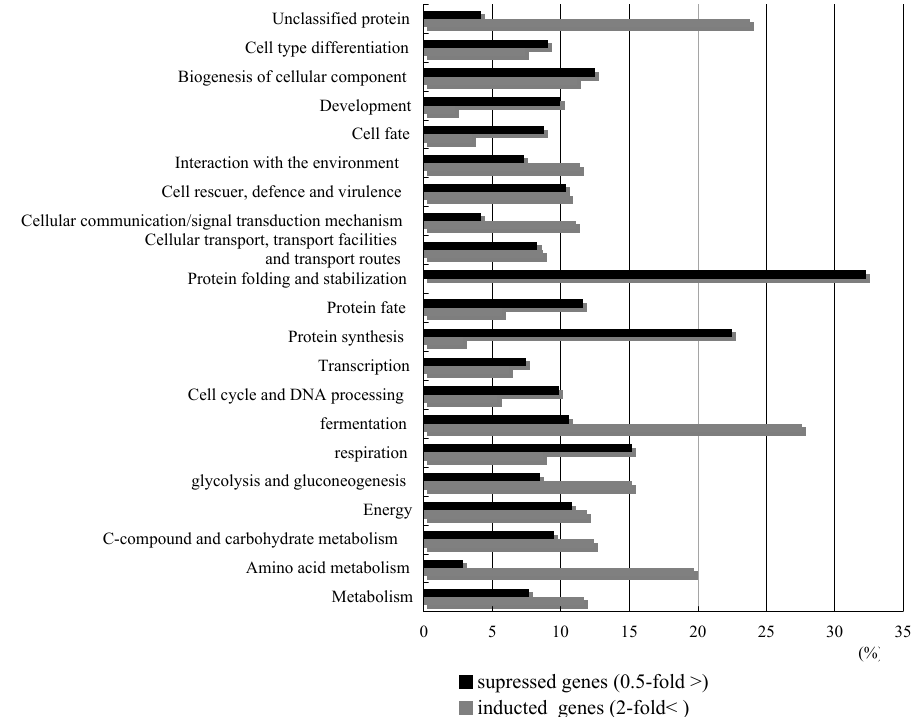
Figure 3. Functional categories of induced or suppressed genes by T-2